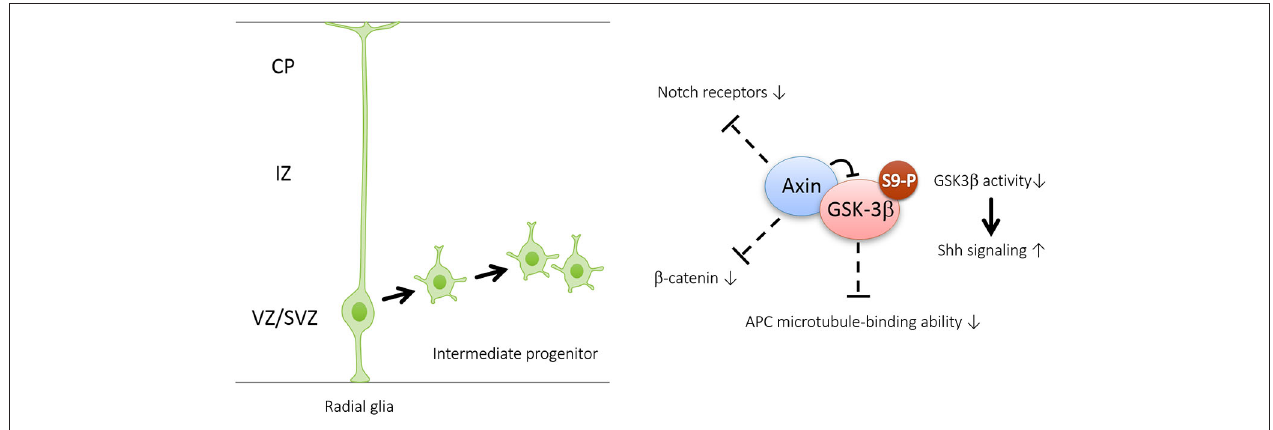
FIGURE 2 | Axin promotes the generation and amplification of intermediate progenitors by interacting with GSK3 β in the cytoplasm . Axin is well-characterized as a “master” scaffold for various signaling proteins including GSK3 β , β -catenin, Notch and adenomatosis polyposis coli (APC)—all of which are known to control neurogenesis. well as APC-regulated division plane.